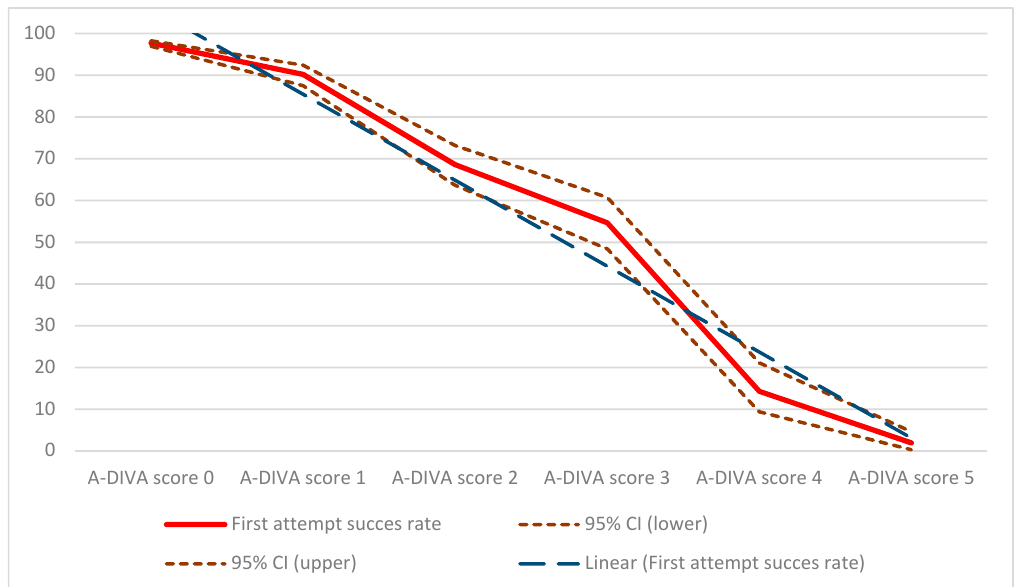
Figure 1. First attempt success rates by the depending A-DIVA (Adult Difficult Intra Venous Access) score. Solid line (red) = first attempt success rate. Dashed line (brown) = 95% confidence interval, divided into a lower and upper bound. Striped line (blue) = linear trend line of the first attempt success rates. Table 5. Comparison of the level of performance of the modified A-DIVA scale in the different included units.